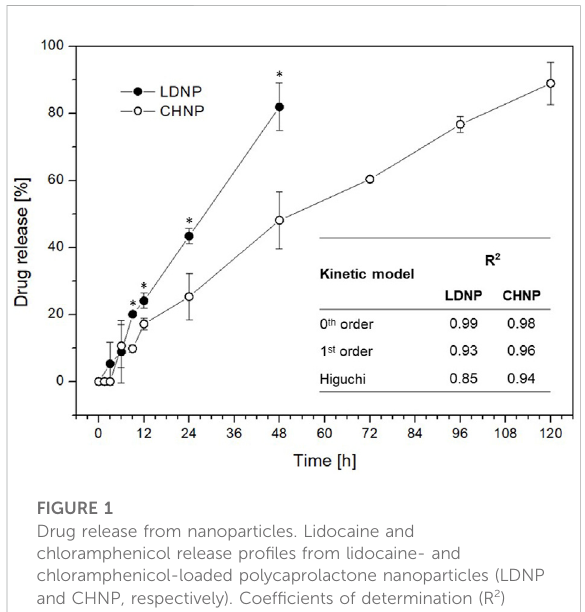
FIGURE 1 Drug release from nanoparticles. Lidocaine and chloramphenicol release pro fi les from lidocaine- and chloramphenicol-loaded polycaprolactone nanoparticles (LDNP and CHNP, respectively). Coef fi cients of determination (R 2 ) for three different fi tting models: 0 th order, 1 st order, and